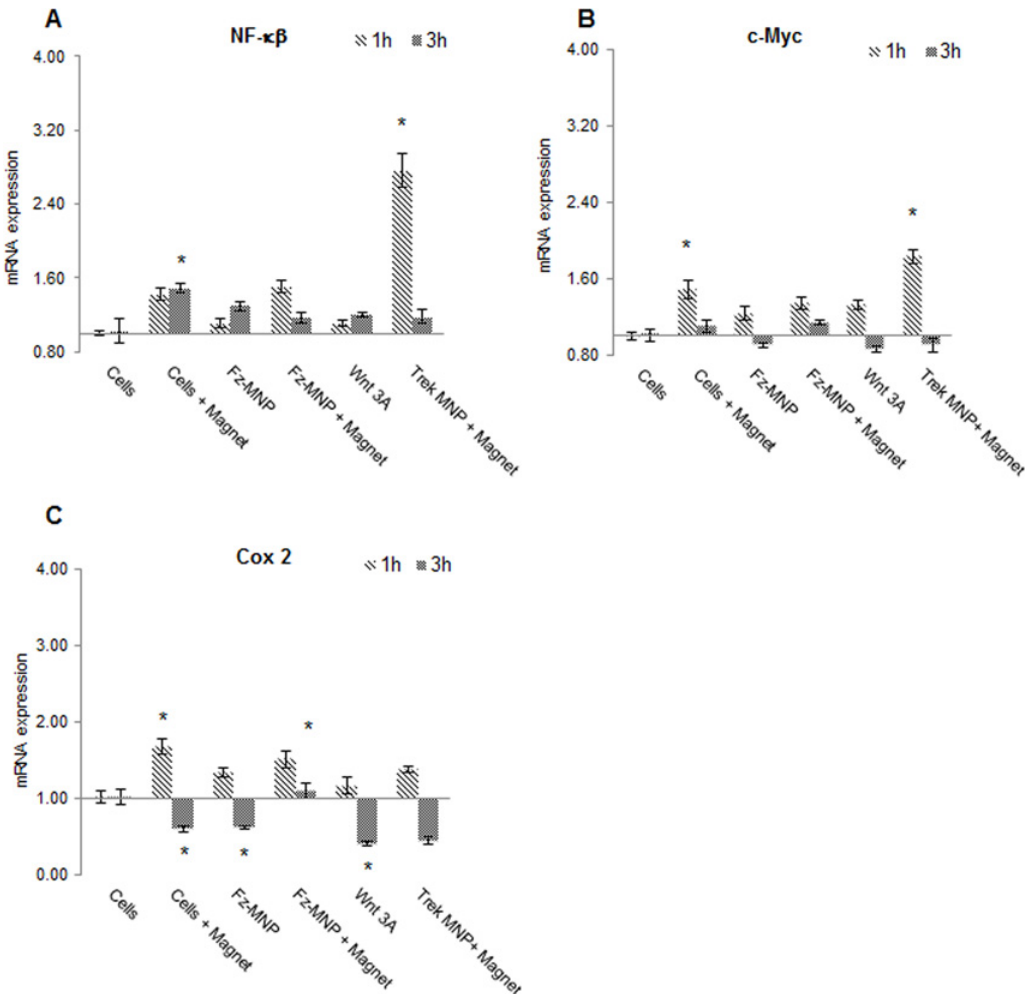
Fig 6. Anti-Frizzled MNP alter expression of Mechanosensitive genes. Gene expression analysis of mechano responsive genes (NF- κ B, c-Myc, Cox 2) in response to anti-frizzled particles (Fz-MNP) or control particles (Trek-MNP) and magnetic field stimulation was evaluated using quantitative real-time PCR after 1h and 3h treatment. NF- κ B gene expression (A) was increased by Trek-MNP (compared to cells + magnet control) after 1h. Magnetic field treatment alone also increased NF- κ B expression (compared to cells only control) after 3h. Treatment with Fz-MNP or Wnt 3A both showed similar but minor shifts in NF- κ B gene expression. c-Myc expression (B) was increased after 1h treatment with magnetic field treatment alone (cells + magnet) with an added increase when used in conjunction with Trek-MNP. Treatment with Fz-MNP or Wnt 3A again both showed similar but negligible shifts in c-Myc expression. COX 2 gene expression (C) was shown to be significantly increased after 1h by magnetic field treatment alone but a decrease in expression was observed after 3h. Treatment with Fz-MNP (without magnet) or Wnt 3A both caused significant decreases in COX 2 expression after 3h treatment. Treatment with Fz-MNP (+magnet) was shown to significantly increase COX 2 expression when compared to Cells + magnet control after 3h. Figures show mean fold change in gene expression normalised to GAPDH, Error bars represent SEM, n = 4, ANOVA p < 0.05 for all genes, * denotes p <